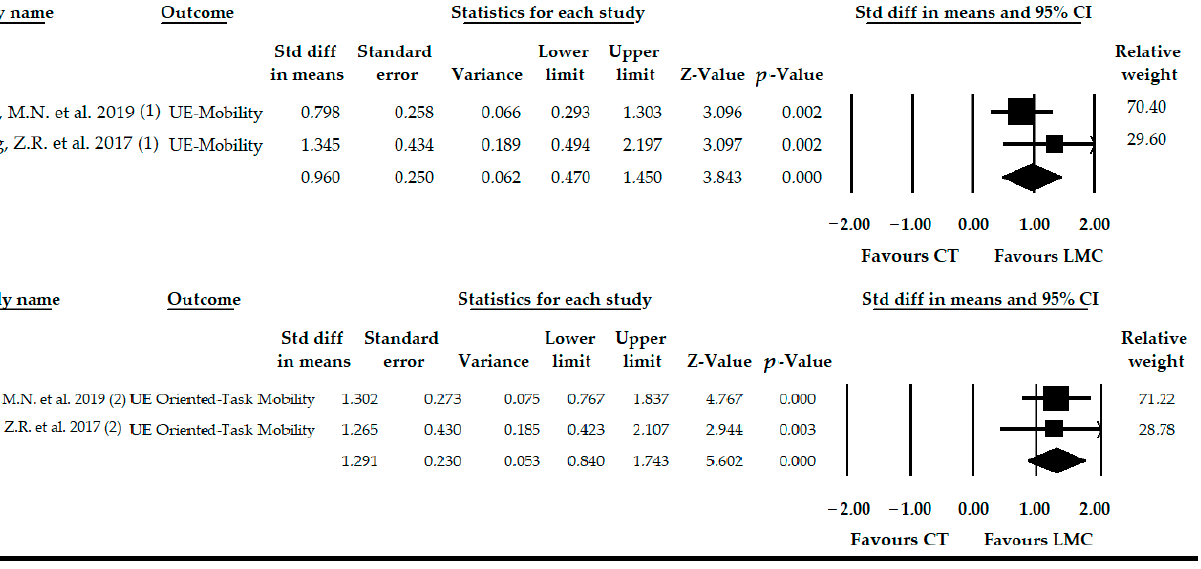
Figure 2. Forest Plot of the effect of Leap Motion Controller (LMC)-based therapy on recovery of the upper extremity (UE) mobility and the UE mobility-oriented task in patients with stroke.